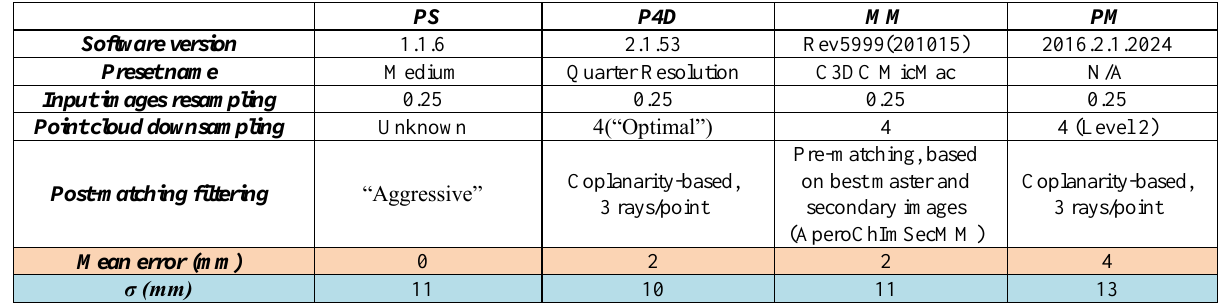
Table 1. Dense matching settings for the Rohan Albris dataset and the results of its comparion to laser scanner